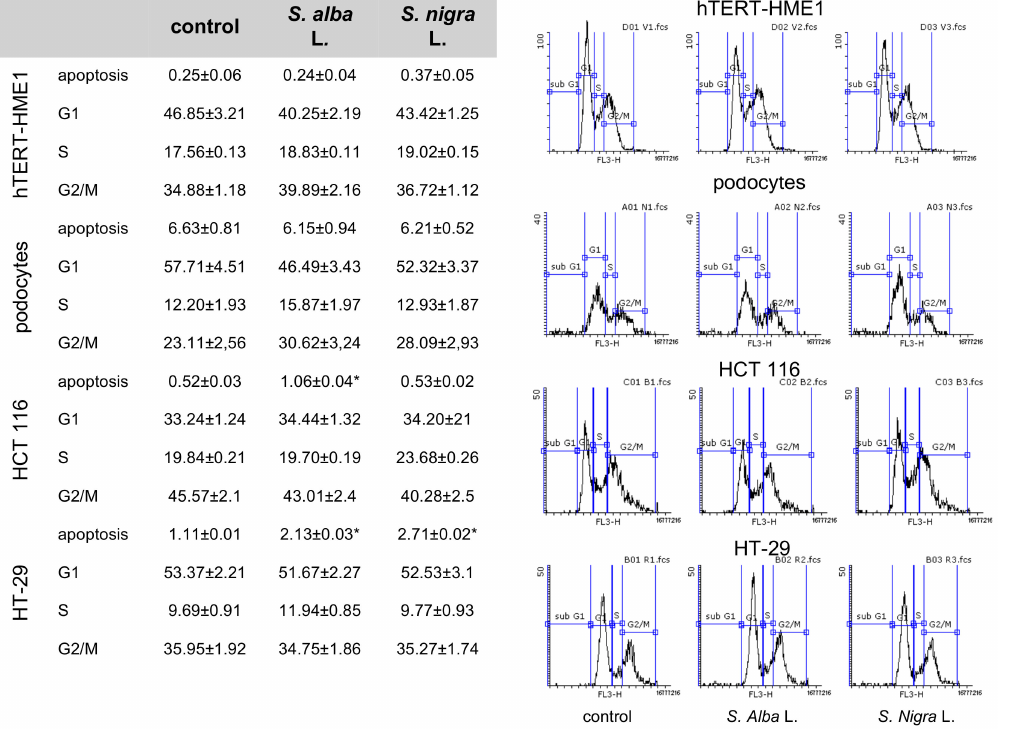
Figure 3. Effect of Sinapis alba and Sinapis nigra seed ethanolic extracts on cell cycle. Values are percentage of cells in each phase of the cell cycle, as a mean ± SEM (n = 3) ( p < 0.05 compared with the control). G1: Gap 1; S: synthesis; G2: Gap 2; M: